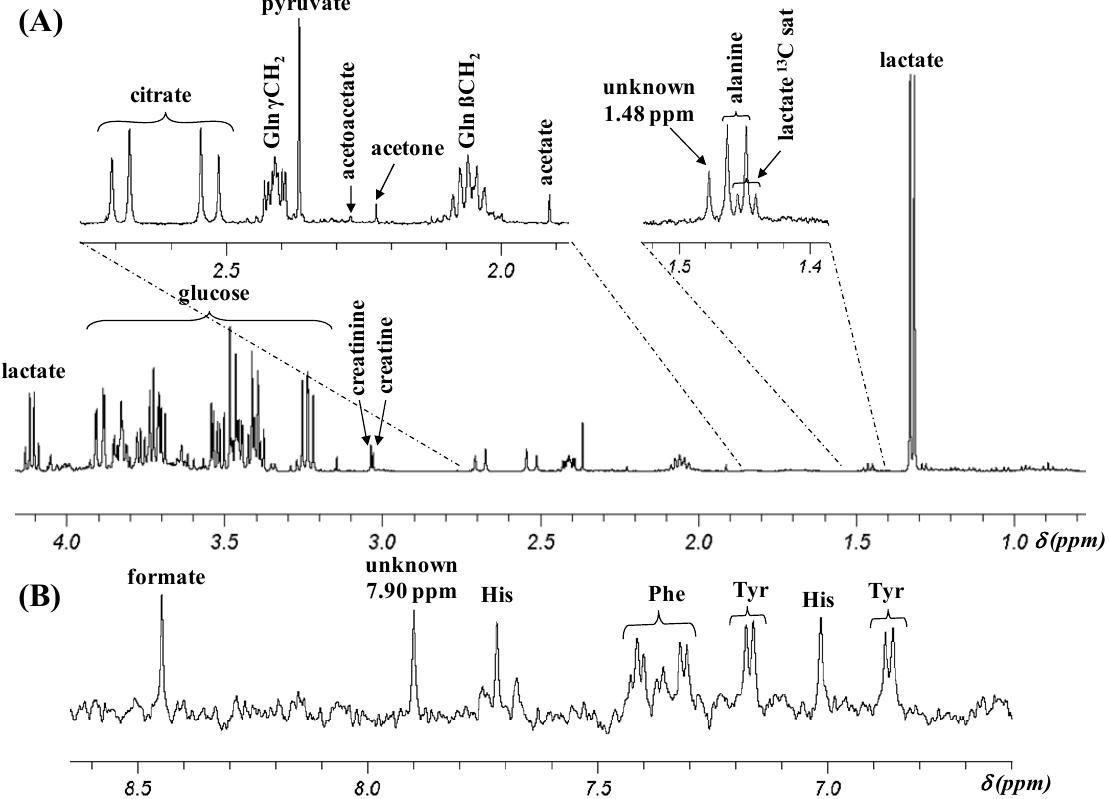
Figure 1. Representative 1 H NMR spectrum of a CSF sample containing 33% D recorded at 298K and pH 8.7. ( A ) 0.8–4.2 ppm region, LB = 0.3 Hz; ( B ) 6.6–8.6 ppm region, LB = 2.5 Hz. Gln: glutamine; sat: satellite; His: histidine; Phe: phenylalanine; Tyr: